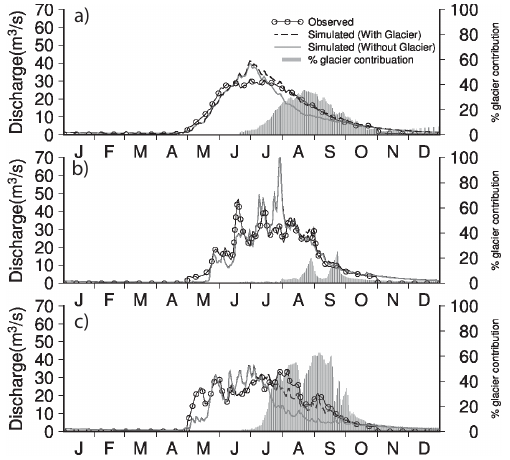
Fig. 12. Comparison of simulated mean annual daily discharge with and without glacier model configurations along with glacier melt contribution in the upper Bow River basin for (a) 1981–2007, (b) cold year (1999) and (c) warm year (1998). The daily observed streamflow data were only recorded from May–October since